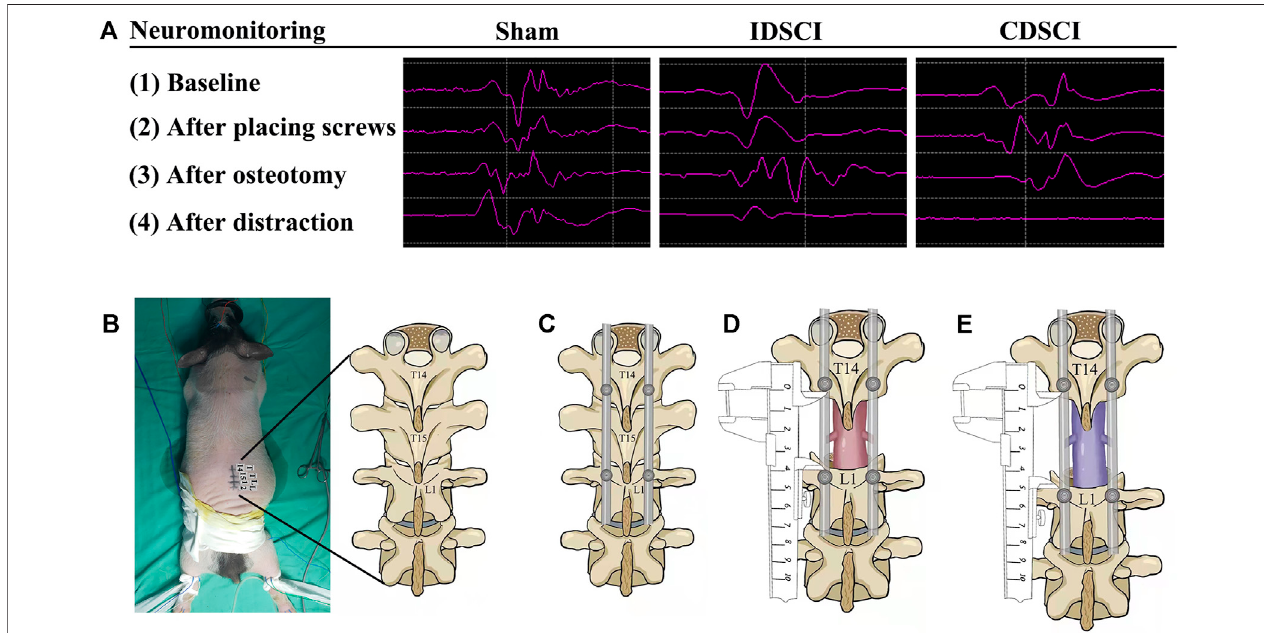
FIGURE 1 | Intraoperative MEP changes in pigs of three different groups, and the schematic diagram of surgical procedure of the porcine DSCI model establishment. (A) Representative images (baseline, after placing screws, after osteotomy, after distraction) of MEP responses were recorded in the gastrocnemius musclesofporcinehind limbs during DSCIsurgery. (B) Amidline longitudinal incision wasmade, and thelaminae from T14,T15,and L1 were exposed withcoagulation cauterythroughout. (C) Pediclescrewsandrodswereusedto fi xT14andL1temporarily. (D) GlobalcolumnosteotomywasperformedatT15undertheprotection of a root retractor, and the T15 vertebral body and adjacent discs were completely resected. (E) A spreader was used to pull the spine gradually, and the distance between the T14 and L1 pedicle screws was measured before and after distraction.